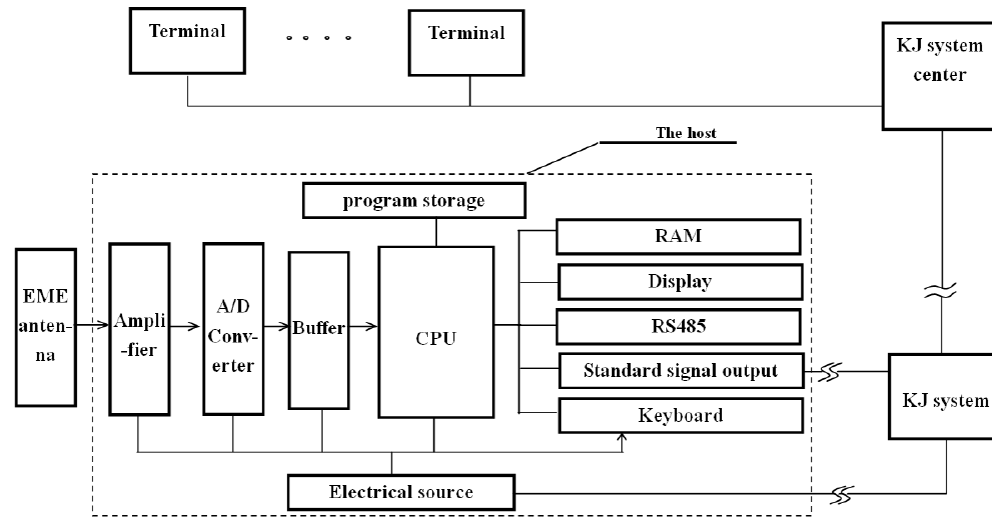
Figure 2. KBD7 Coal and rock dynamic disaster noncontact EMR (Electromagnetic radiation Emission) monitor principle diagram.